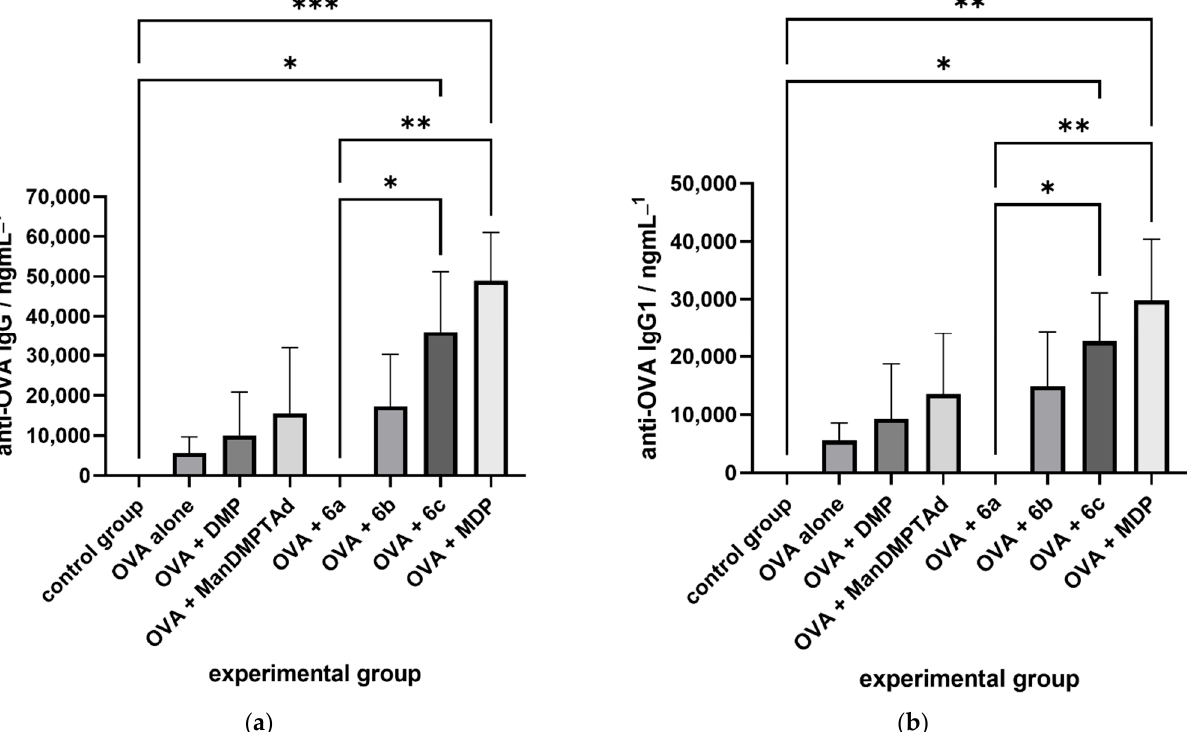
Figure 2. The effect of synthesized DMPs on the production of total anti-OVA IgG ( a ) and subtype of anti-OVA IgG1 ( b ) in BALB/c mice immunized with OVA as an antigen. Bar graphs represent the average values of individual mice from each group ( n = 5). * p < 0.05, ** p < 0.01 and *** p < 0.001 denote statistical significance between indicated groups.